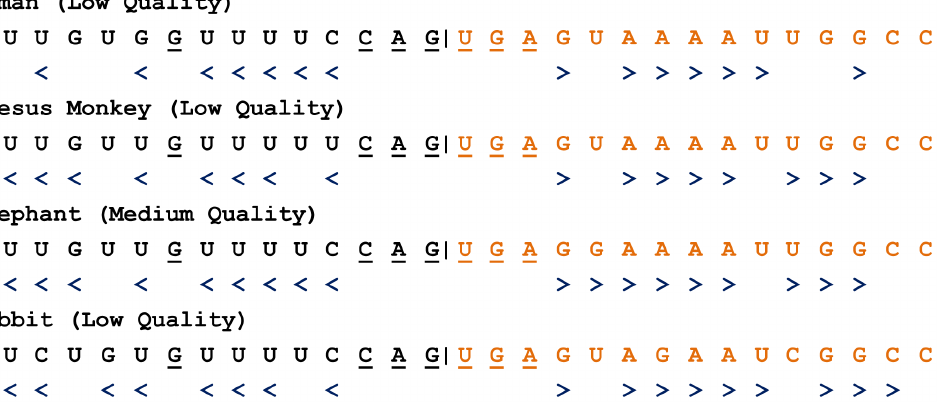
Figure 5. Sequence alignment of the IREs at the intron-exon boundaries of UROS from four species. ‘‘ . ’’ and ‘‘ , ’’ represent the base pairing of the RNA secondary structure. The potential IRE consensus loop sequence, CAGUGN, and the unpaired nucleotide G are also shown with respect to the location of the IRE hairpin. The intron-exon boundary is indicated as |.